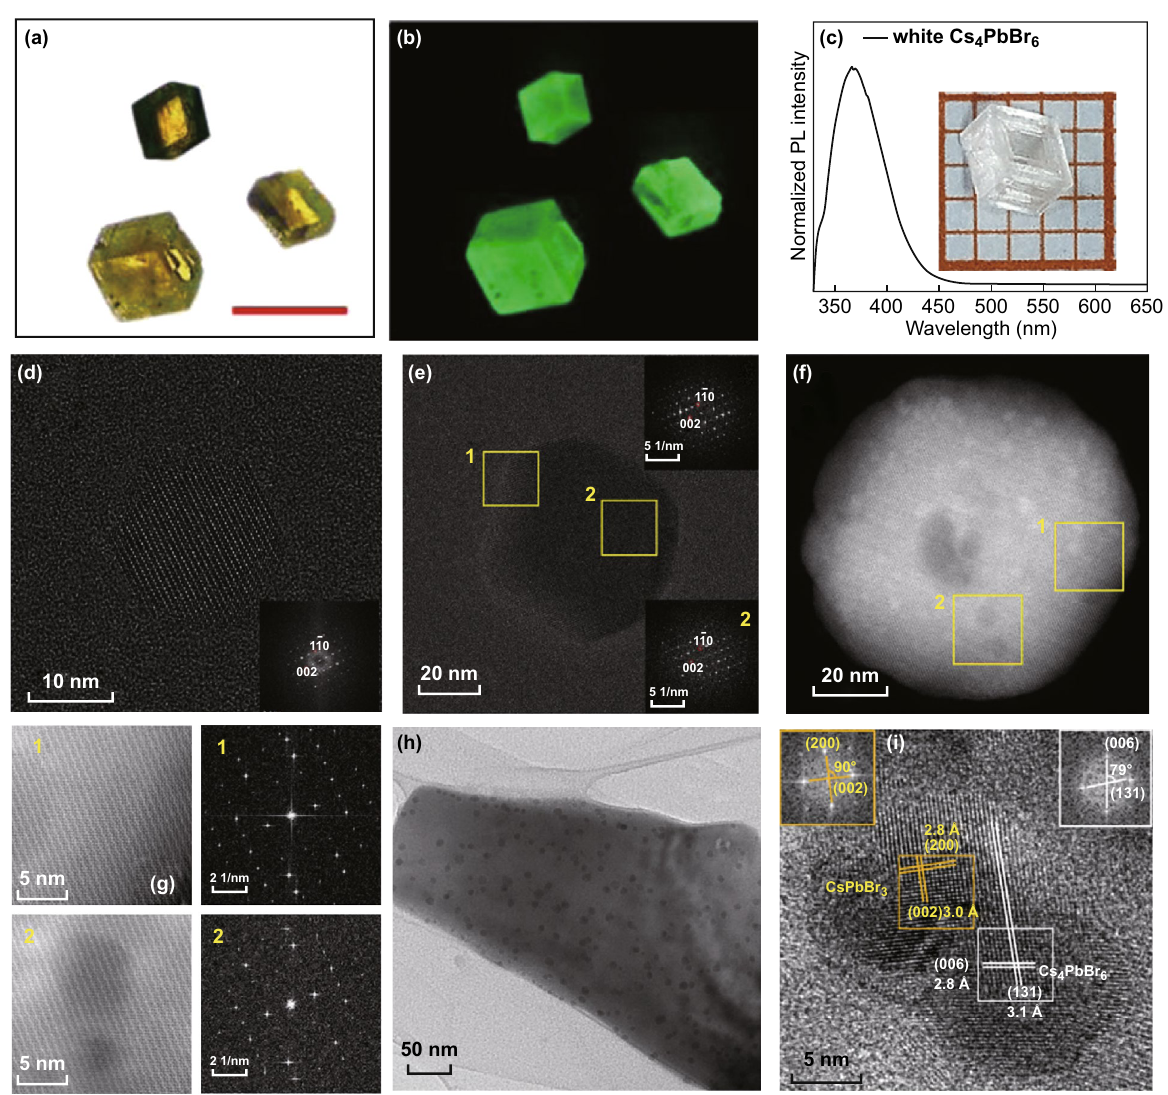
Fig. 7 a , b Optical and fluorescent microscope pictures of emissive Cs 4 PbBr 6 single crystals. Scale bar: 500 μm [63]. c Photograph of a mil- limeter-sized non-emissive